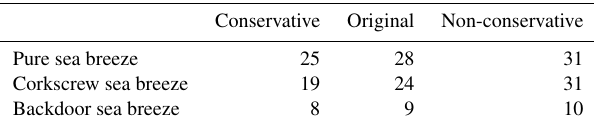
Table 6. Number of identified events for each sea breeze type using conservative, original and non-conservative selection